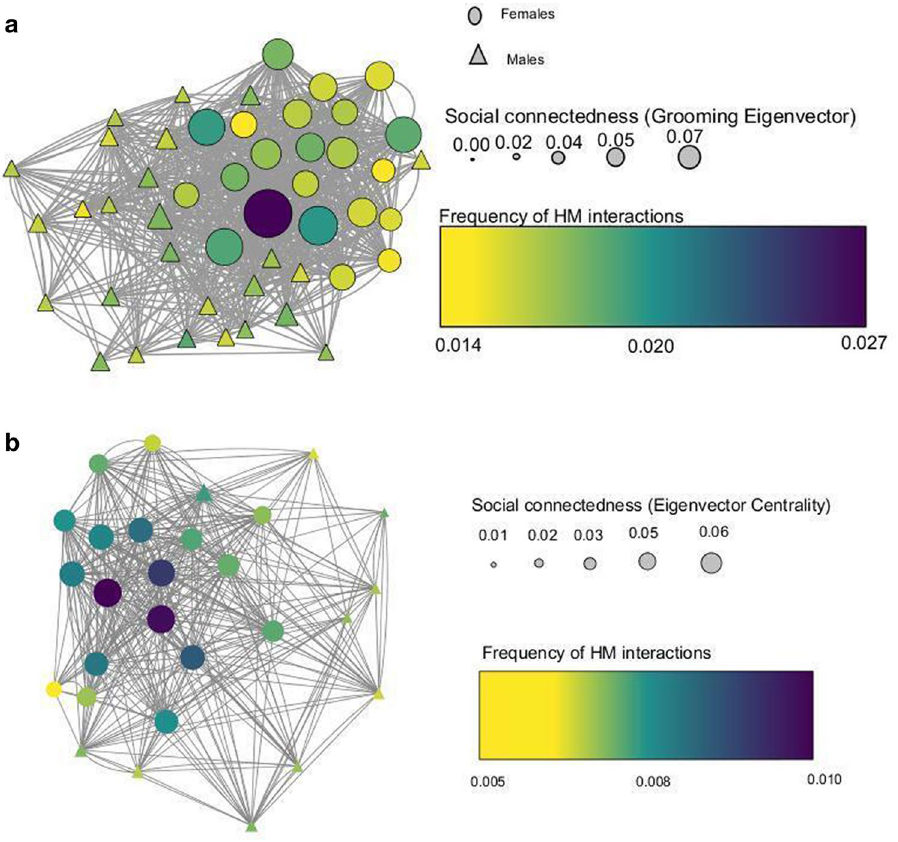
Figure 3. Grooming social networks of each of two bonnet macaque groups showing the effect of eigenvector centrality on the frequency of human–macaque interactions. Nodes indicate individual macaques, and are sized by grooming eigenvector centrality (larger nodes indicate higher values). Node color indicates frequencies of human–macaque interactions (darker colors indicate higher frequencies). Figure was created using Cytoscape (Version 3.7.2: https ://cytos